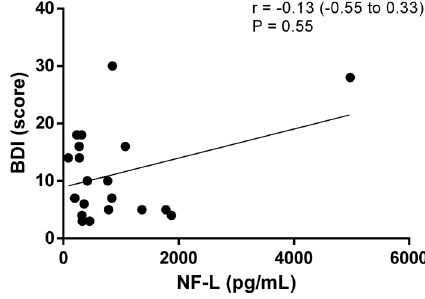
Figure 2. Correlation analysis between scores of the Hospital Anxiety and Depression Scale-anxiety (HADS-A) and neuro fi la- ments light chain (NF-L)